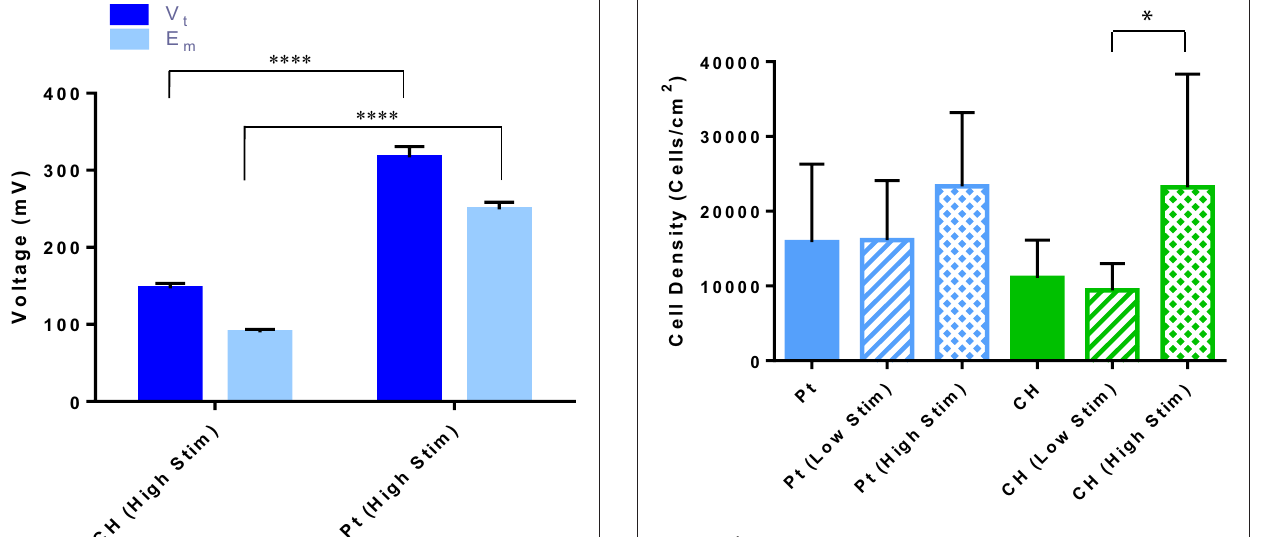
FIGURE 4 | The estimated OEC density on each sample as determined by the cell concentration measured with the Tali. Error bars represent the standard error of the mean. ( t -test, *significant difference, p < 0.05, N =